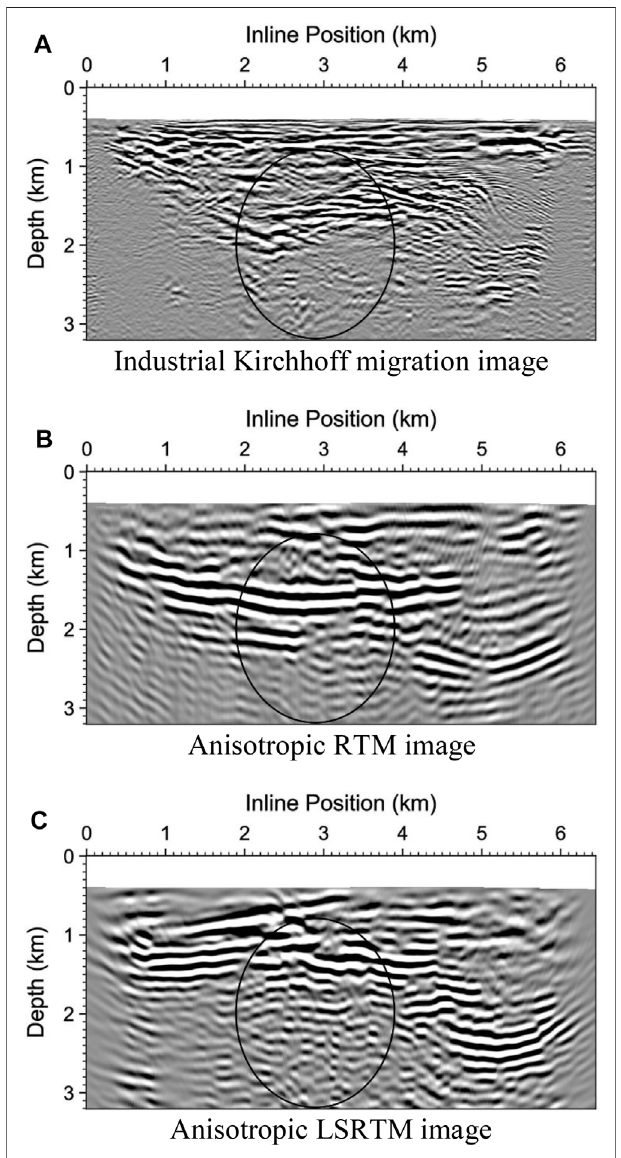
FIGURE 14 | Subsurface migration images of Line 5 at Pirouette Mountain produced using various migration methods: (A) Industrial Kirchhoff migration, (B) Anisotropic RTM, (C) Anisotropic LSRTM. The image within the ellipse region in (C) shows high-resolution structures in the deep region that are not well imaged in (B) and (A)